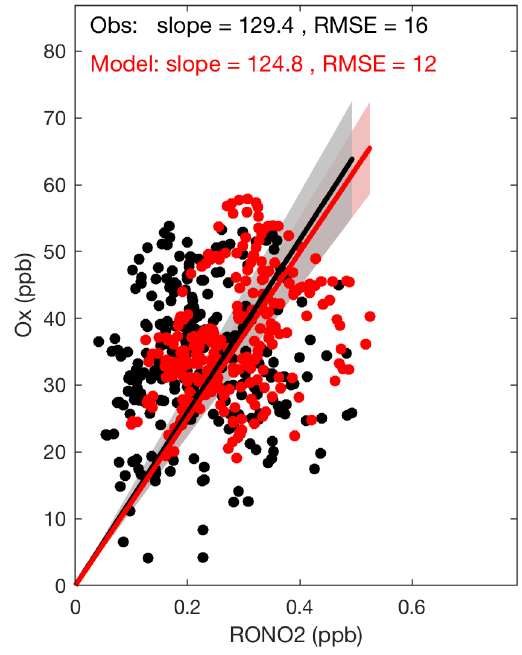
Figure 7. The modeled and observed correlations between CH 2 O and organic nitrates during daytime at SOAS. The slope shows the best-fit line, with an intercept allowed to differ from zero to consider the possibility of background CH 2 O. The panel includes slopes of the lines and root mean square errors